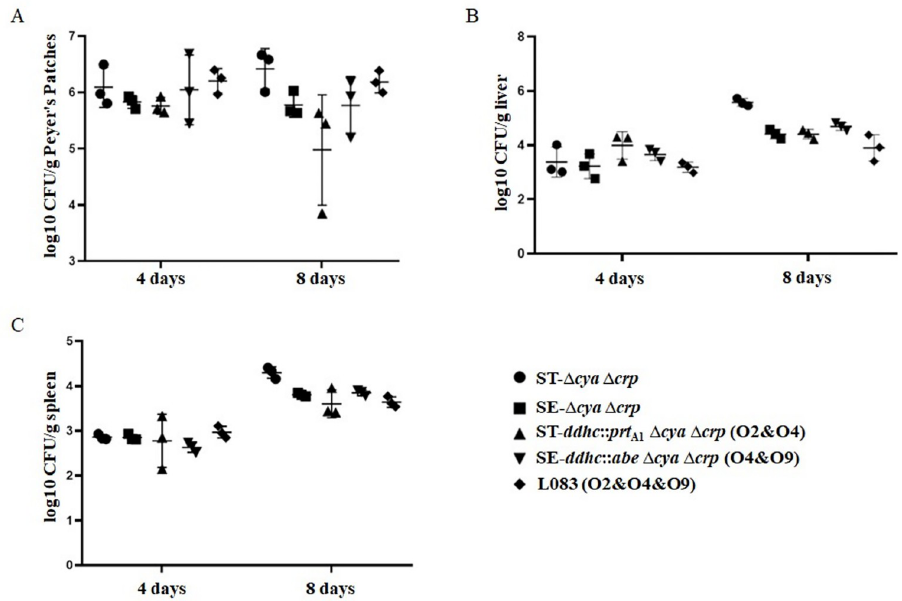
Fig 5. Colonization of murine Peyer’s patches, livers and spleens by live attenuated S . enterica vaccines. Colonization of mouse Peyer’s patches (A), livers (B) and spleens (C) 4 and 8 days post-inoculation were shown. The horizontal lines represent the means, and the error bars represent the standard deviation of the